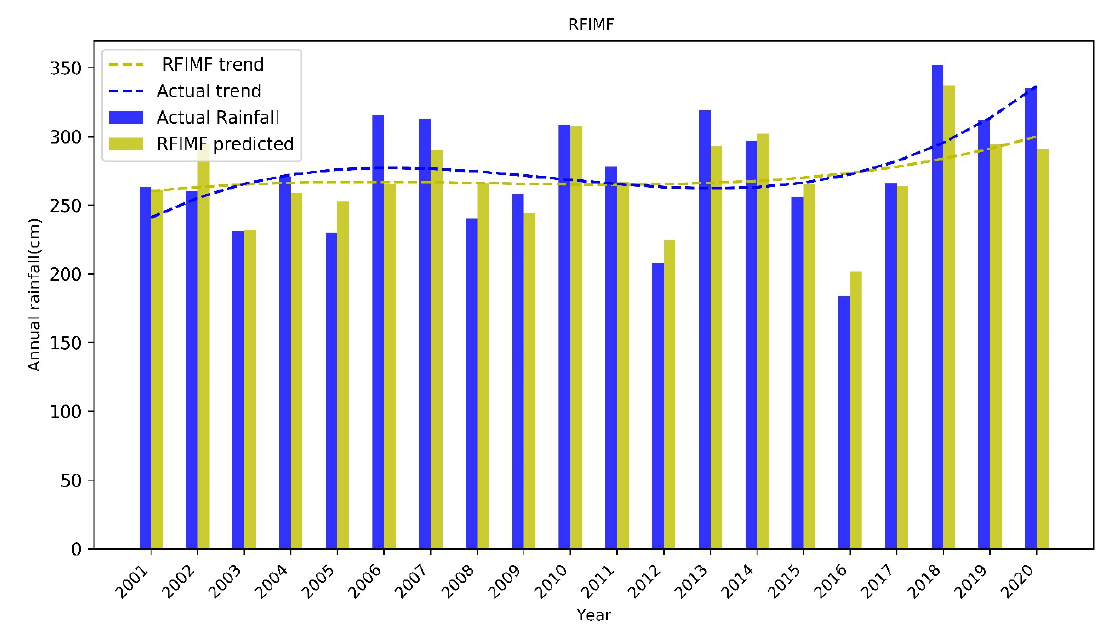
Figure 8. A bar plot of the predicted and observed annual rainfall for RF–IMF model.